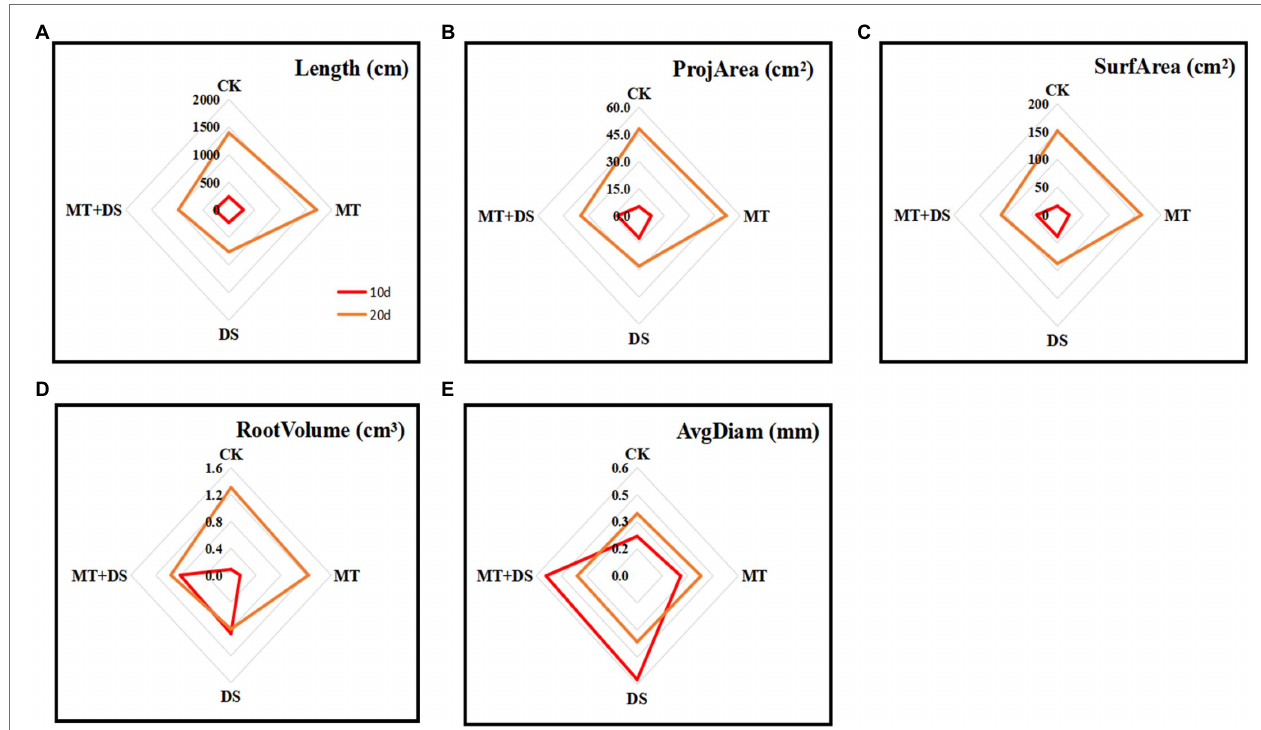
FIGURE 6 | MT at 20 μ M concentration was used as the optimal priming concentration for triticale seeds, unprimed +70–75% relative water content as CK, primed +70–75% relative water content as MT, unprimed +40–45% relative water content as DS, and primed +40–45% relative water content as MT+DS. (A) Root length, (B) root projarea, (C) root surface area, (D) root volume, and (E) root avgdiam of triticale potted seedlings on days 10 and